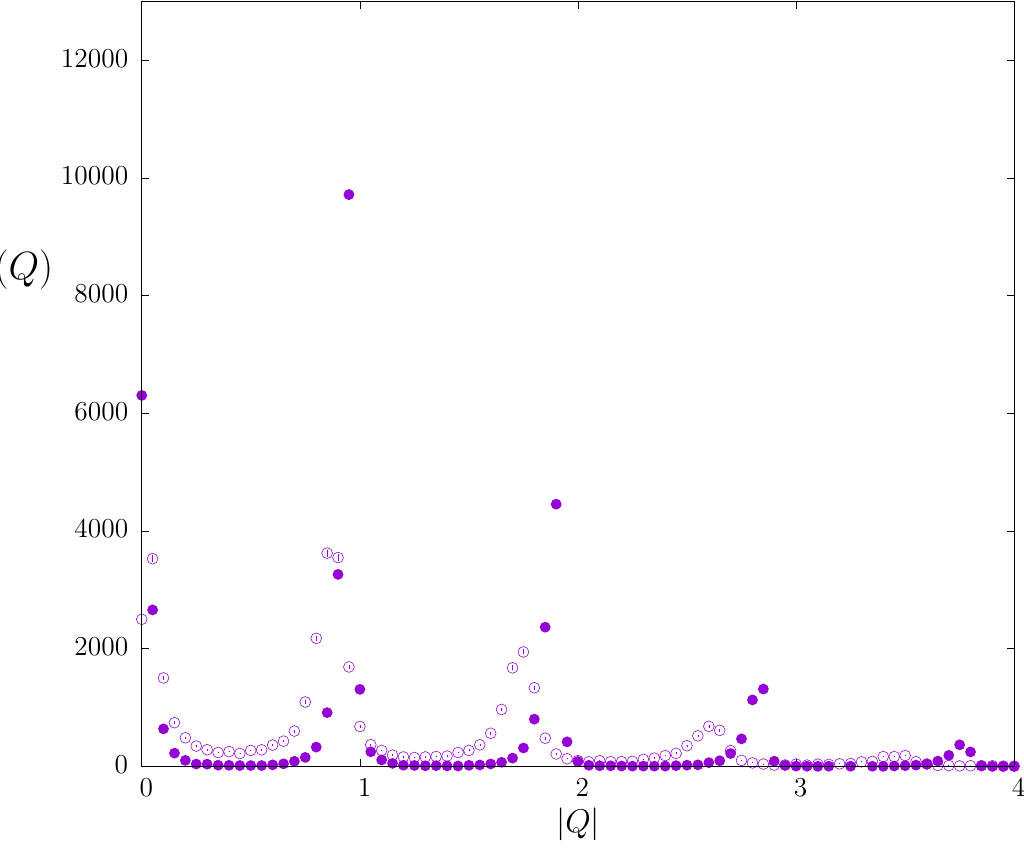
Figure 26 . Histogram of lattice Q after 4 cooling sweeps, ◦ , and after 20 cooling sweeps, • on a 14 3 20 lattice at β = 6 . 0625